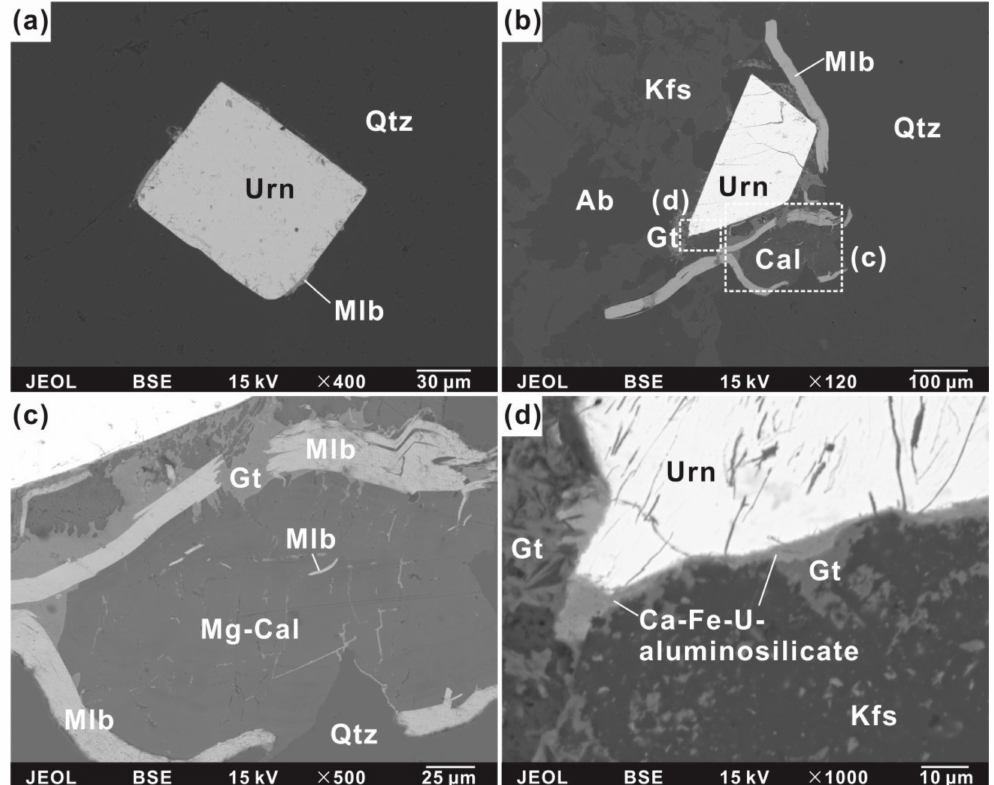
Figure 3. Backscattered electron images of uraninite and associated minerals from the Guangshigou deposit. ( a ) Uraninite included in quartz. ( b ) Uraninite associated with molybdenite and calcite along interstices of quartz and K-feldspar. ( c , d ) Details of ( b ) showing molybdenite inclusion in Mg-bearing calcite and a Ca-Fe-U-aluminosilicate together with goethite around uraninite Abbreviations: Ab—albite, Cal—calcite, Cof—coffinite, Gt—goethite, Kfs—K-feldspar, Mlb— molybdenite, Qtz—quartz,